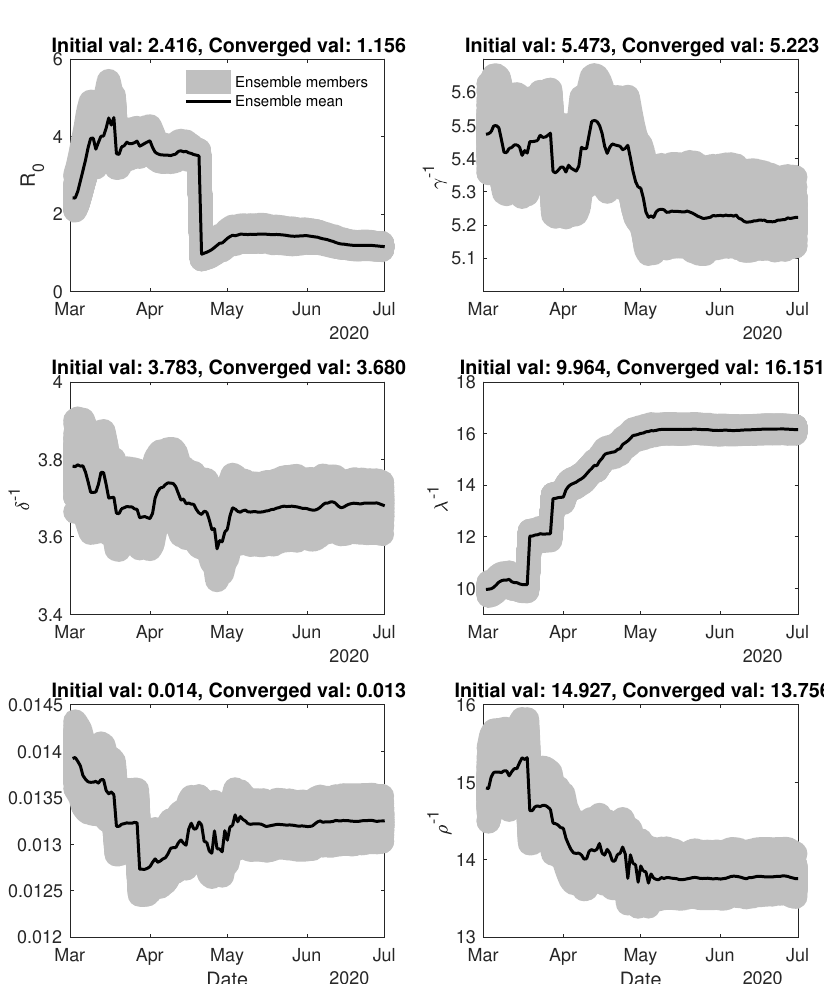
Figure 4. Time series of the estimated model parameters using the Joint-EnKF with 200 ensemble members. Initial and converged values for each parameter are also displayed.